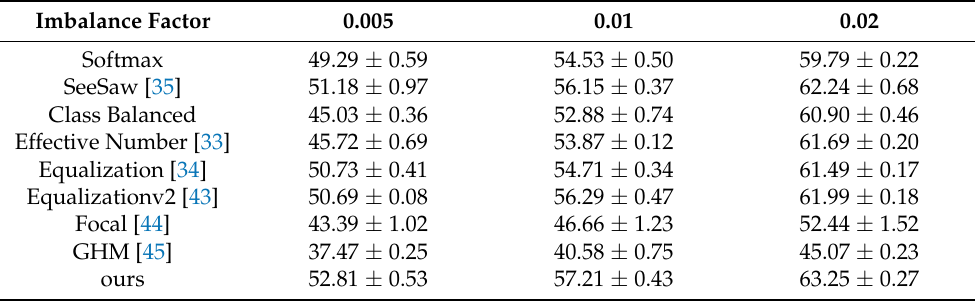
Table 4. Comparison results of the proposed method with other similar advanced methods on the long-tailed NWPU-RESISC45 dataset with imbalance factors of 0.005, 0.01, and 0.02. The values in the table are the top1 OA